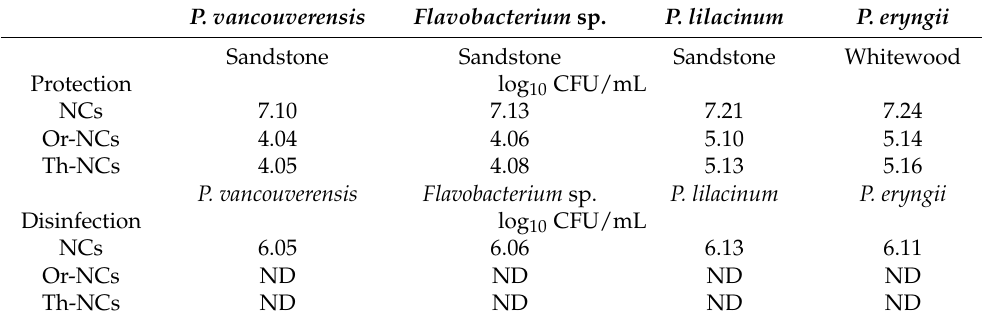
The areas covered by the microbial cells on the agar plates were determined by digital Table 3. Concentration of microorganisms (log 10 CFU/mL) grown on printed agar plates. optical microscopy. The bacterial and fungal areas were calculated using ImageJ analyz-